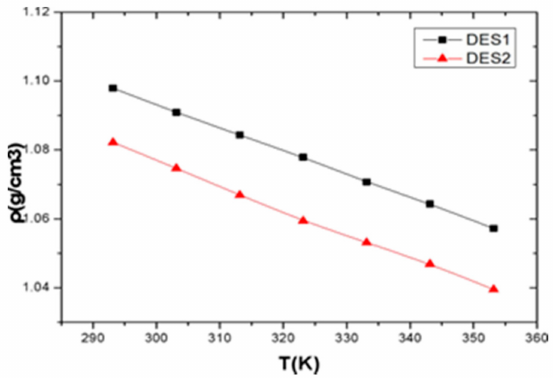
Figure 2. Variation in experimental densities of DES1 and DES2 for increasing temperature.